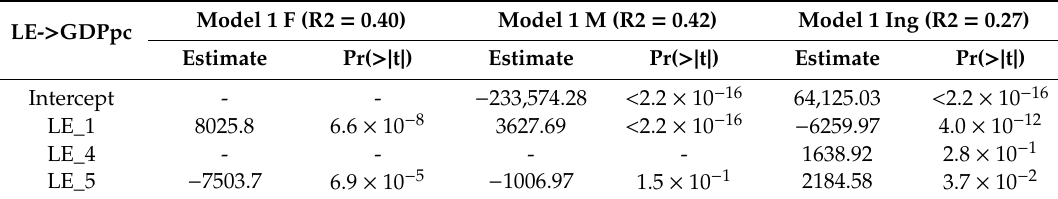
Table 5. Regression analysis output—a multivariate approach to the relations of life expectancy and economic prosperity.